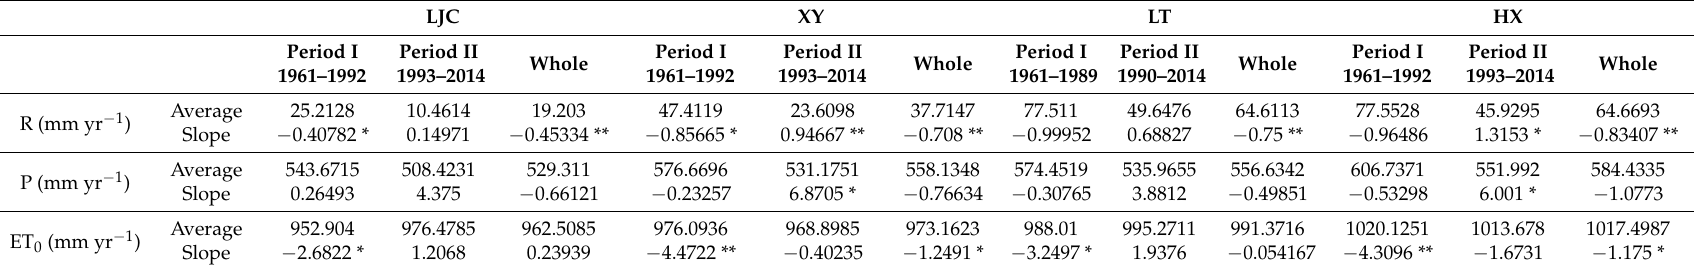
Table 1. Averages and slope of runoff (R), precipitation (P), and potential evotranspiration (ET 0 ) in the Weihe River basin during 1961–2014. LJC, Lin Jia Cun; XY, Xian Yang; LT, Lin Tong; HX, Hua